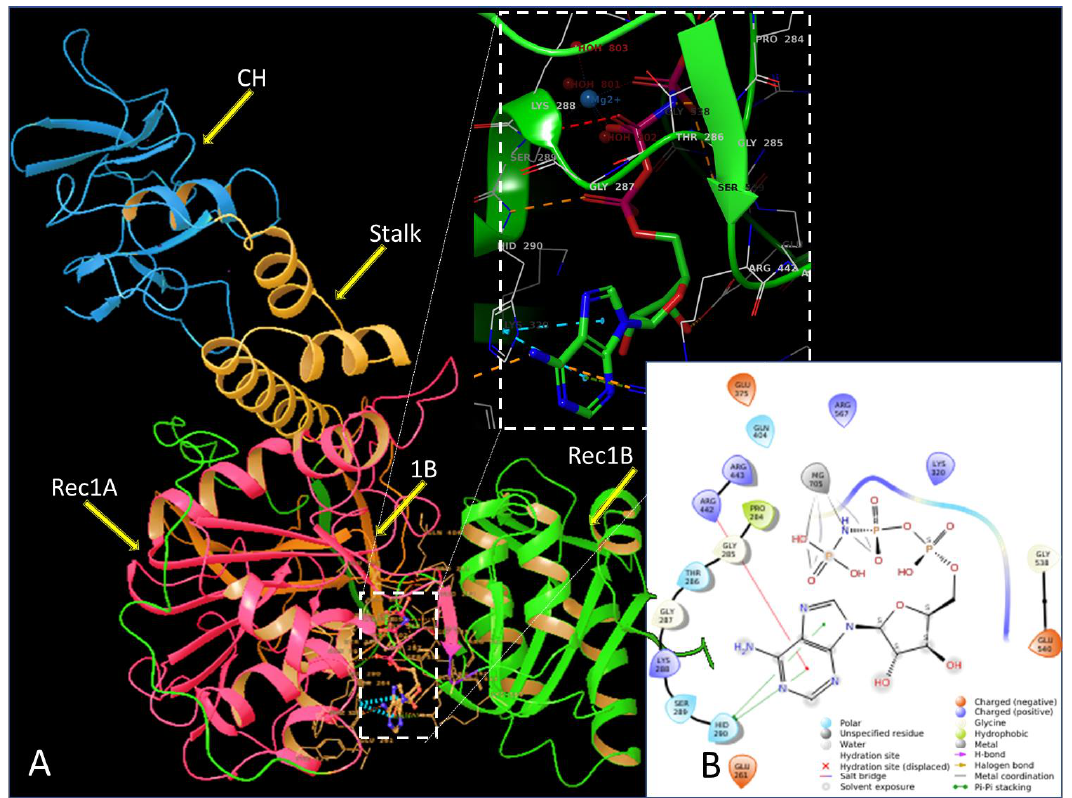
Figure 1. ( A ) Schematic representation of SARS-CoV-2 Nsp13 helicase protein fragment (67kDa) from polyprotein open reading frames (ORFs) encoded by the SARS-CoV-2 RNA genome. Different domains are colored individually in ribbon format. The ATP hydrolysis essential for RNA-helicase and RNA 5′ triphosphatase activity required for viral 5′ mRNA cap formation involves six key residues (Lys288, Ser289, Asp374, Glu375, Gln404, Arg567) within the ATP binding site. This ATP binding site is within the cleft between the 1A and 2A RNA binding domains [27] and is predicted to be the region targeted by cyclobutanones as described in this paper. The central helix (CH) domain in blue is the N-terminal zinc-binding domain. The CH domain is connected to the main protein through a helical stalk domain (yellow) and the Beta barrel domain (1B: orange). SARS-CoV-2 has two RecA like domains 1A (pink) and 2A(green) that unwind double- stranded DNA or RNA in a 5′ to 3′ direction using ATP hydrolysis as the energy source. The ATP binding site is seen with a bound adenosine monophosphate (AMP) molecule in Protein Data Bank (PDB) ID 7NN0. An expanded view is shown in the inset for visualizing interacting amino acid residue side chains. ( B ) Schematic 2D representation of the ATP binding domain and key interactions depicted as dashed lines.